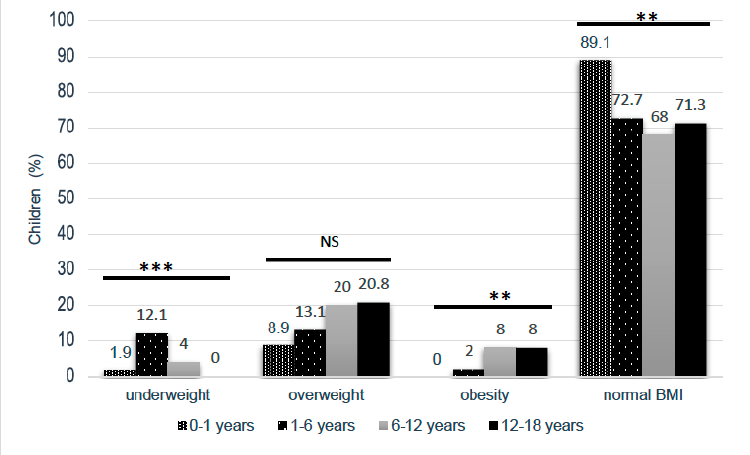
Figure 1. BMI data of the pediatric population, according to age group (*** p < 0.001, ** p < 0.01, NS no significant, χ 2 test ).